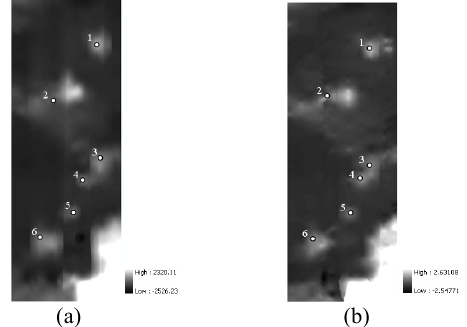
Figure 8. The 2D grey-scale images from Chang’E-1 laser altimetry data (a) and SELENE laser altimetry data (b) with the same 360-m resolution